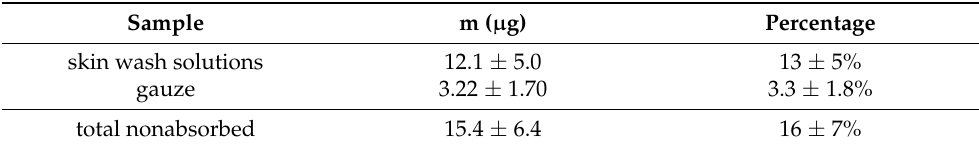
Table 1. STL amount and percentage of the applied dose (96.1 µ g) in skin wash solutions and gauze as well as the total nonabsorbed amount ( n = 20).